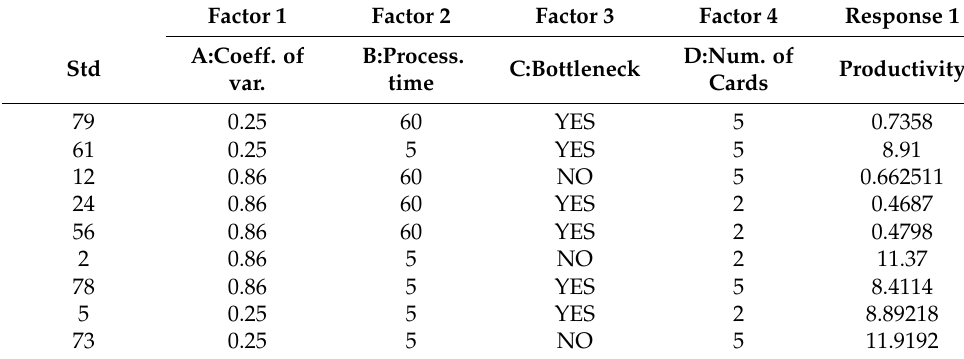
Table A1. Experiment design